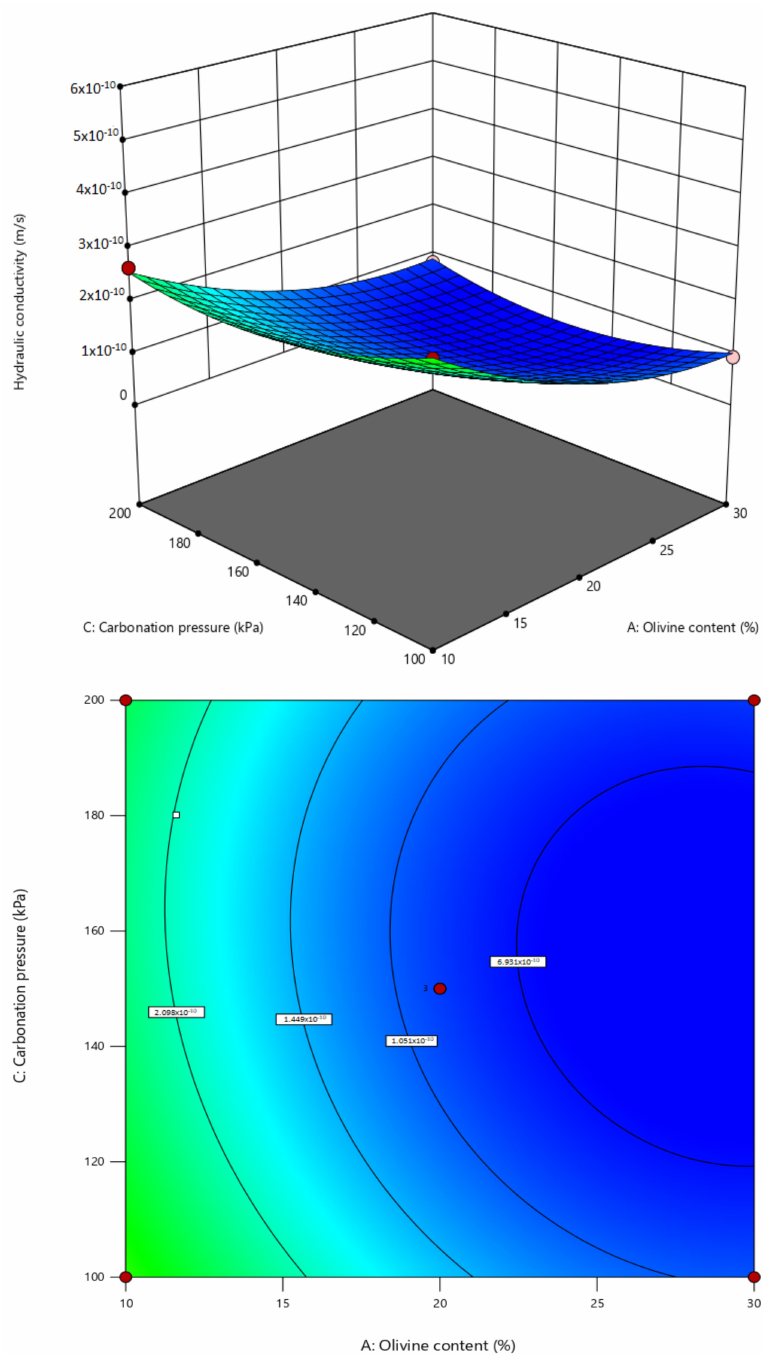
Figure 11. Response surface and contour plots demonstrating the interactive effects of olivine content and carbonation pressure on the hydraulic conductivity while keeping carbonation time at central